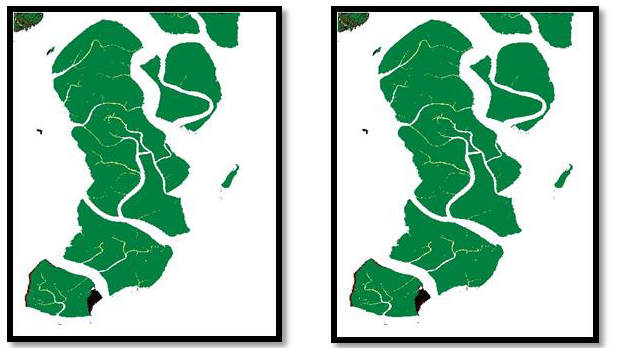
Figure 6: SLAMM output with SLR 0.5metres and subsidence 5mm/year